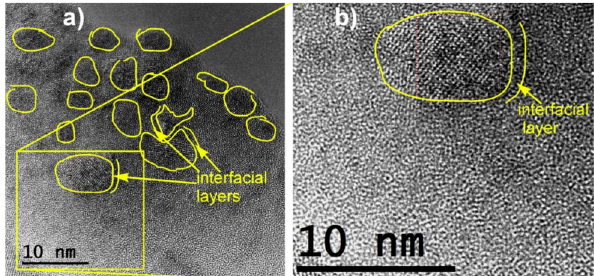
Figure 9. HR-TEM images of a sample LiFe 0.80 V 0.08 PO 4 (G08) heated up to 493 ◦ C: ( a ) a HRTEM image with a crystalline area selected for analysis (a box ), ( b ) a Fourier filtered image of the area marked in ( a ) with inter-plane distances of the LiFePO 4 (Reproduced with permission from ref. [47]. Copyright 2017, Elsevier).